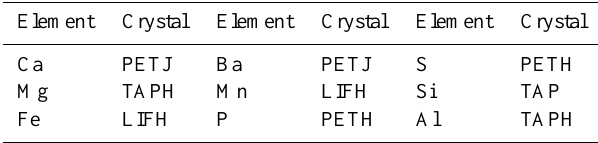
Table A1. Spectrometer crystals used at the EMP for differ- ent elements.